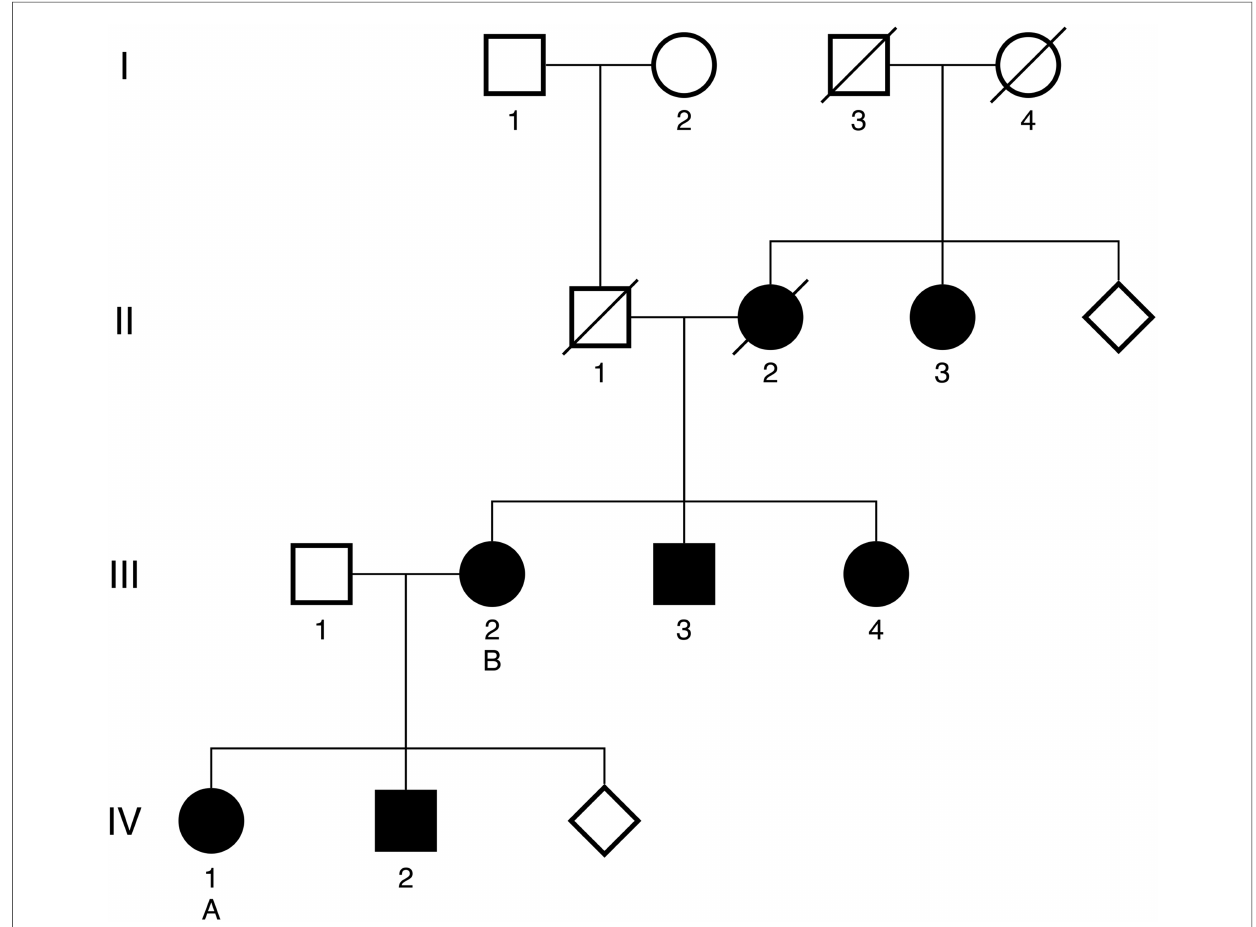
FIGURE 1 Targeted family pedigree. Family members with a con fi rmed diagnosis of HCM are denoted by solid dark shapes. Patient A and patient B are denoted by the letters A and B, respectively. Deceased family members are denoted with a diagonal line. Diamonds represent the presence of additional family members within a generation who have not been diagnosed with